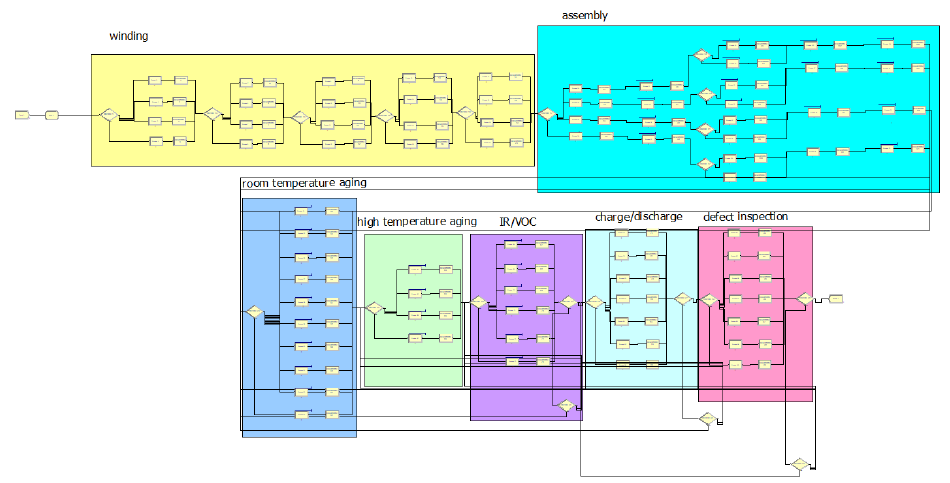
Figure 13. Illustration of the network used to simulate the battery manufacturing process.